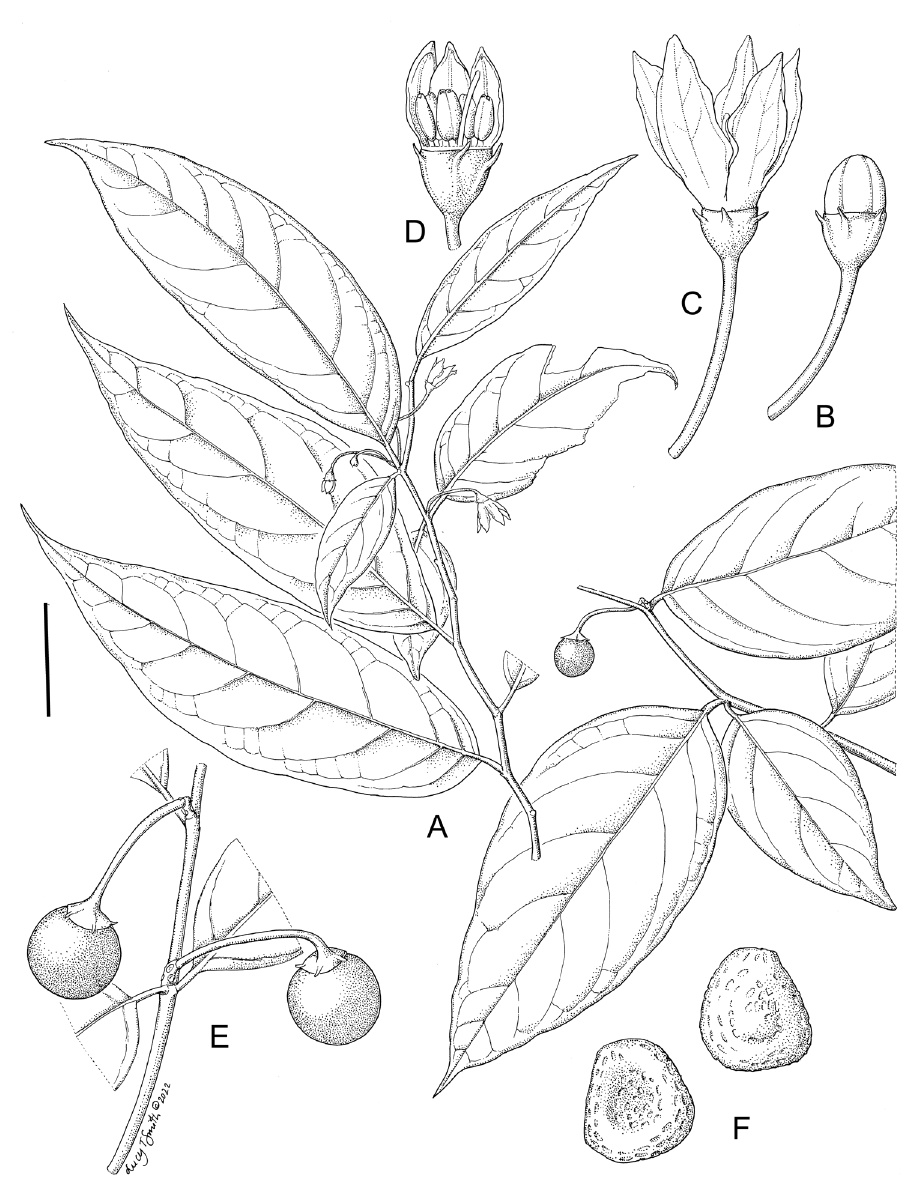
Figure 28. Lycianthes lucens S.Knapp A flowering branch B flower bud C flower D flower bud with petals removed to show stamens E fruiting branch F berries G seeds. ( A, C, E, G Sands et al. 2230 B Sands et al. 2073 ). Drawing by Lucy Smith. Scale bars: 4 cm ( A, E ); 7 mm ( B, C ); 6 mm ( D ); 2 cm ( F ); 2.5 mm ( G